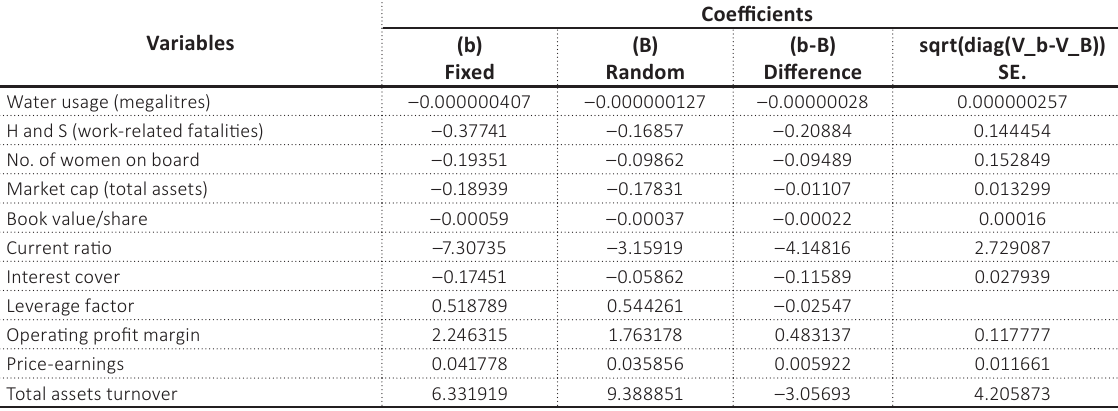
Table 6. Hausman test